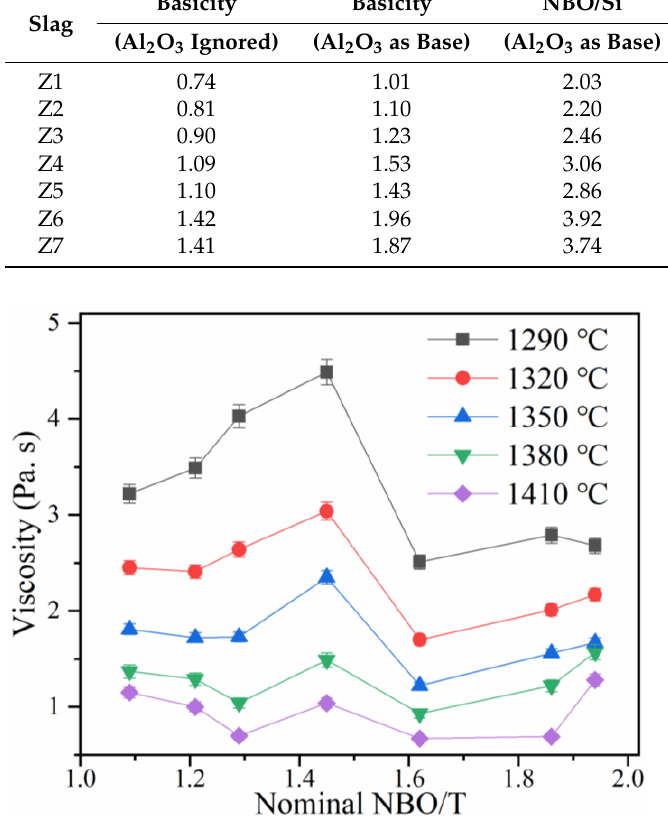
Figure 1. Effect of NBO/T and temperature on slag viscosity.